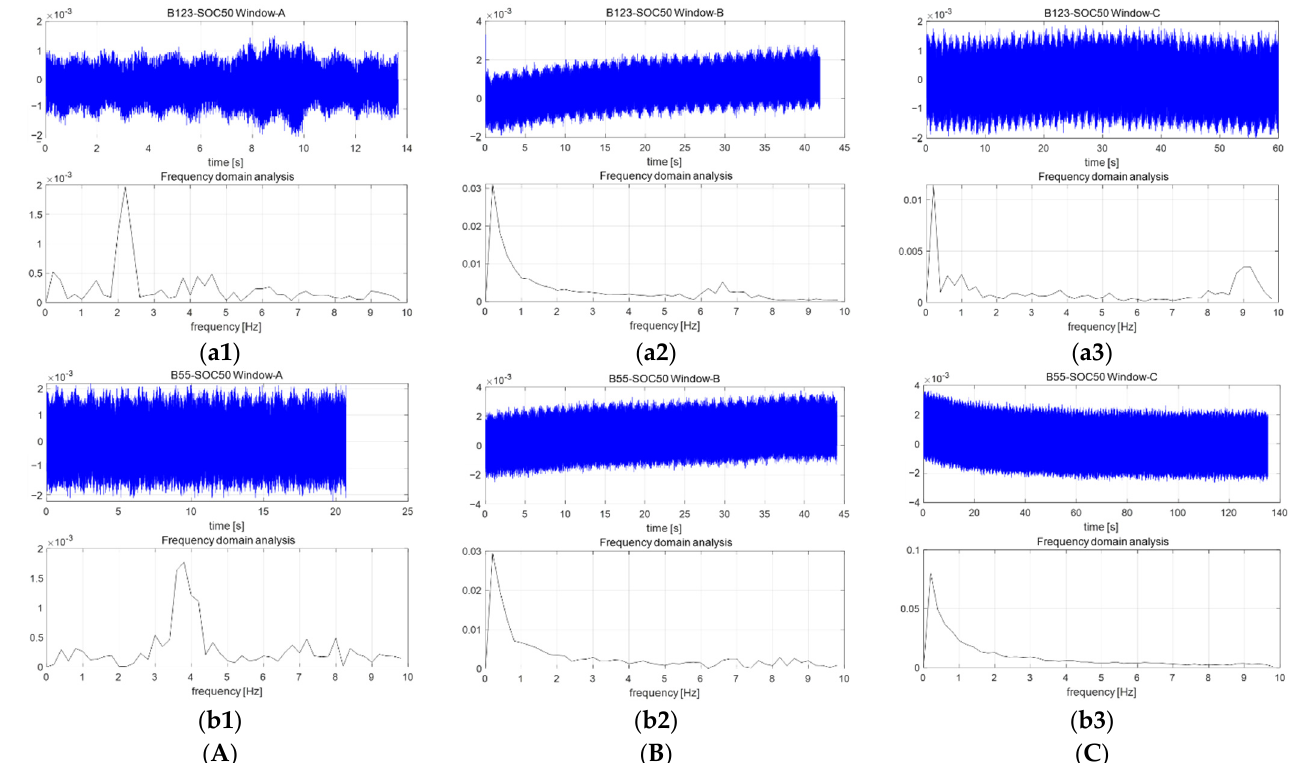
Figure 11. Two cases frequency domain characteristics of windows A–C with initial SOC50 condi- tion. ( A ), acoustic signal before the ESC in ( a1 , b1 ); ( B ), acoustic signal during the ESC in ( a2 , b2 ); ( C ), acoustic signal near-end after the ESC in ( a3 , b3 ).